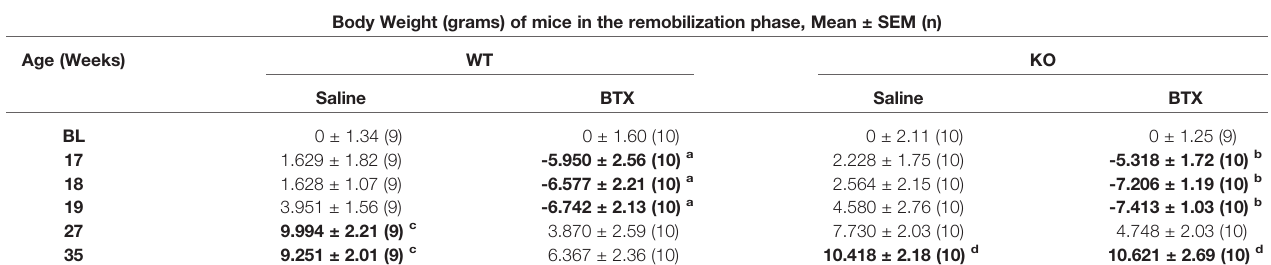
Body Weight (grams) of mice in the remobilization phase, Mean ± SEM (n)